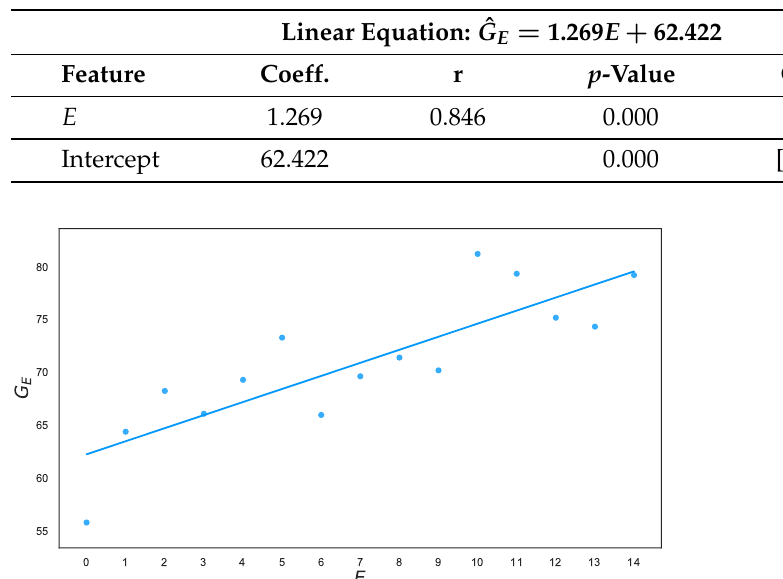
Table 13. OLS Regression summary—Extraversion level Grade against Extraversion level.